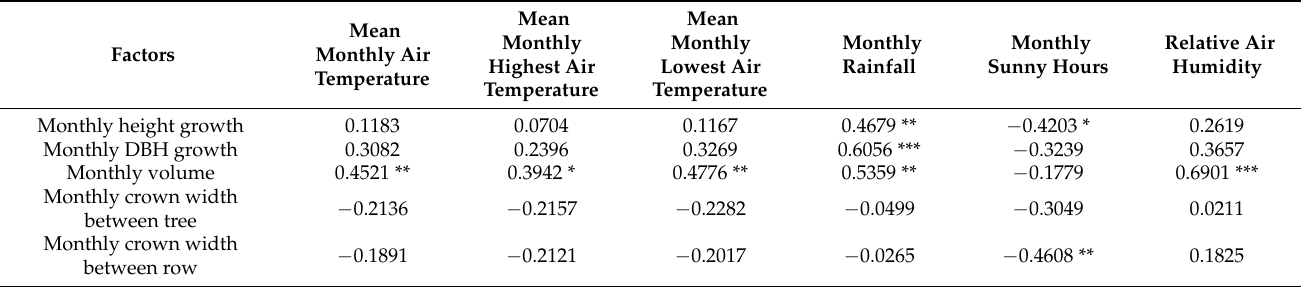
Table 10. The correlation analysis between monthly growth level of C. axillaris and meteorological factors of the previous